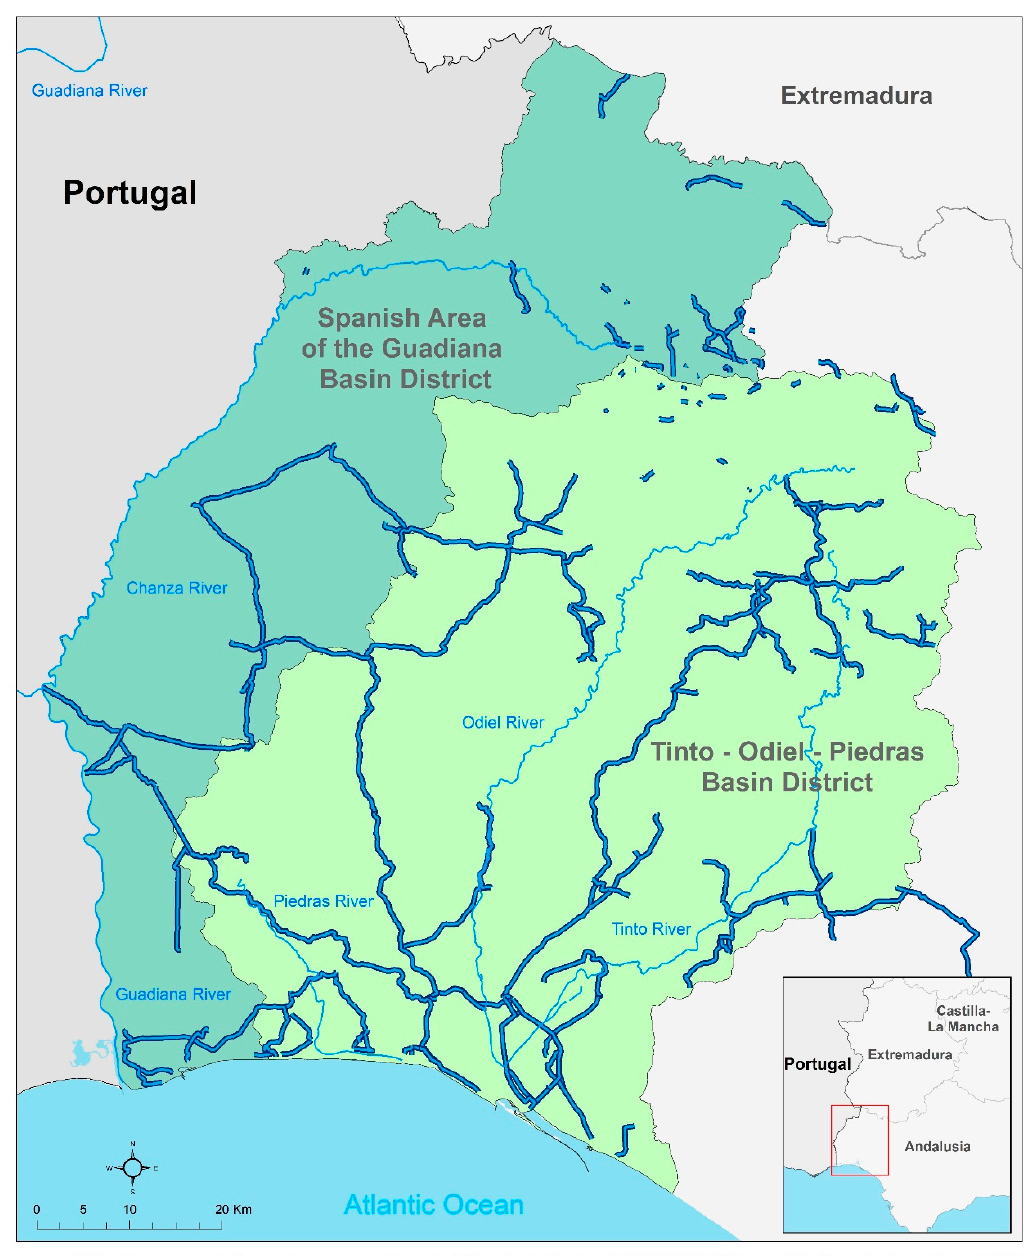
Figure 3. Water conveyance system originating in the intra-community river basin districts of Guadiana and Tinto-Odiel-Piedras. (Source: [54]).